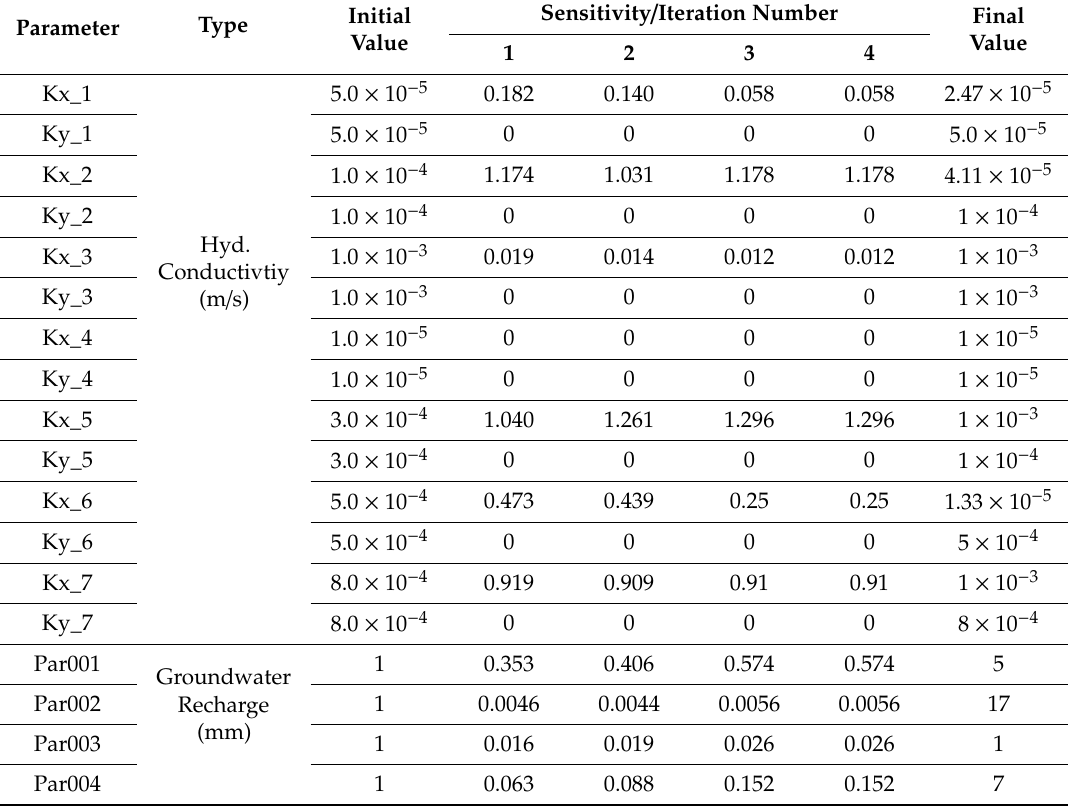
Table 2. Model sensitivity results.